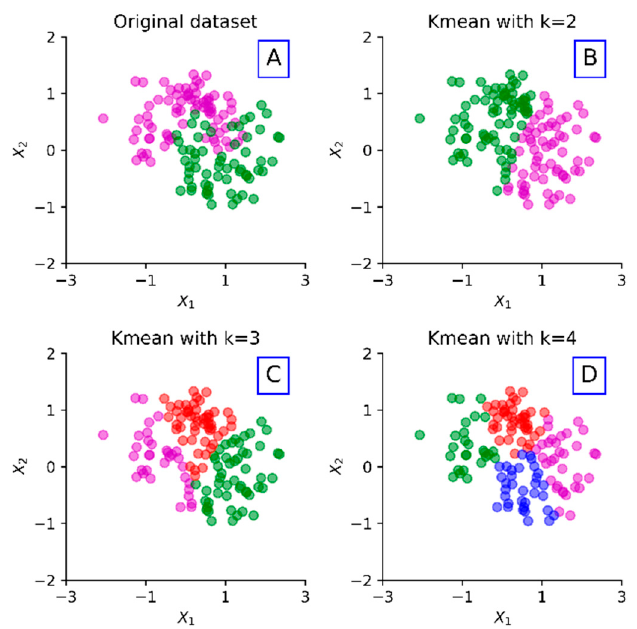
Figure 1. Results of the k -means clustering algorithm with various k values on an example dataset.